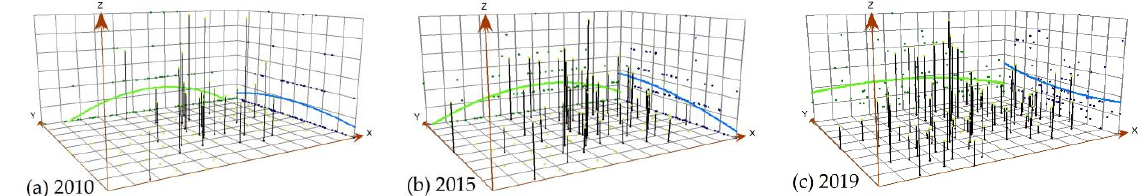
Figure 8. The spatial distribution trend surface analysis plots of A-level scenic spots in